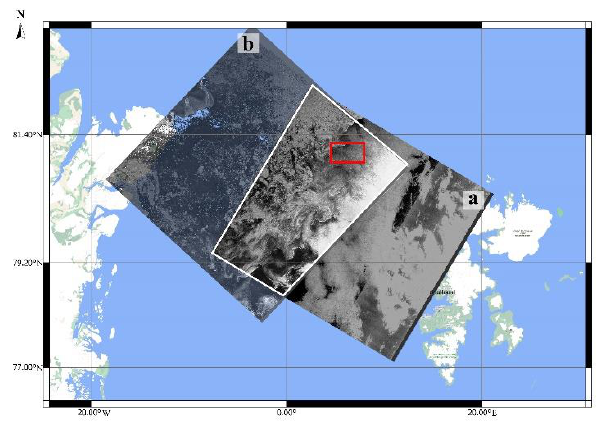
Figure 1 . Position of two sequential Sentinel-1A/B images acquired over Fram Strait on 1 August 2018 at a) 07:11 UTC and b) 08:01 UTC. Red rectangle marks the region enlarged in Figure 2.